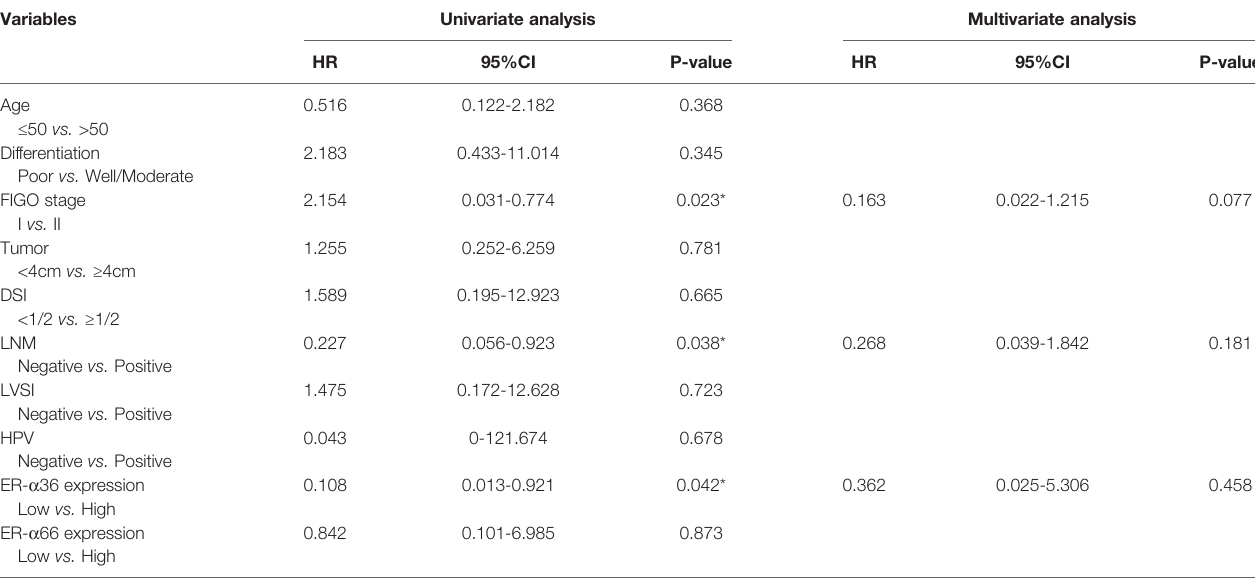
TABLE 4 | Univariate and multivariate analyses of overall survival in cervical AC